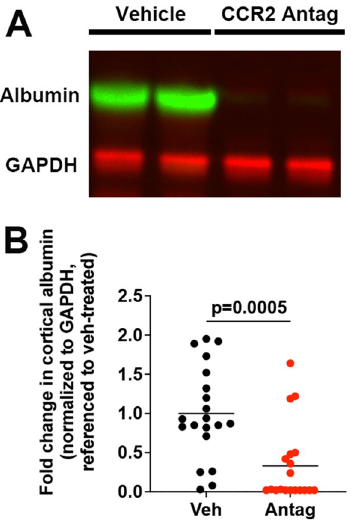
Figure 5. Serum albumin extravasation into the cortex three days after SE was used to evaluate erosion of the BBB. ( A ) Albumin protein levels in cortical homogenates of mice treated with vehicle or CCR2 antagonist after KA-induced SE were measured by Western blot with GAPDH as loading control. Two representative samples from each group are shown. ( B ) Normalized band intensity of the albumin protein relative to that of GAPDH and referenced to the mean albumin/GAPDH ratio in vehicle-treated KA mice. Horizontal bars are at the mean, and each symbol represents data from one mouse. The albumin/GAPDH ratios were compared by unpaired t-test, veh n = 20, antag n = 19. The achieved power to have detected a real difference was 91%.